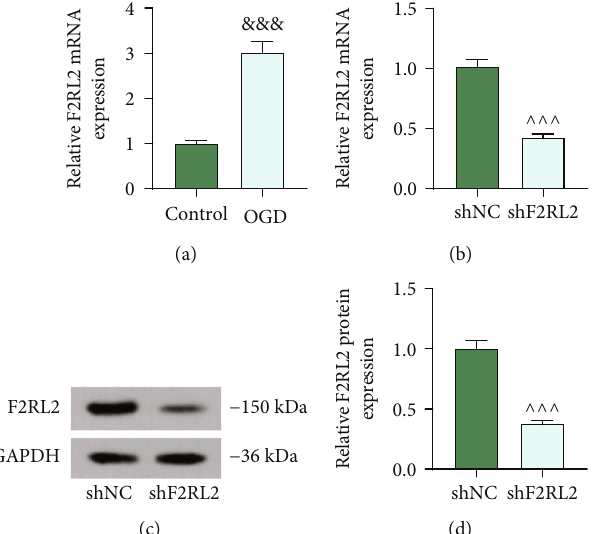
Figure 4: F2RL2 expression was upregulated in OGD-induced HCMs. (a) The expression of F2RL2 in OGD-induced HCMs was evaluated using qRT-PCR. (b – d) After cells were transfected with shF2RL2, the expression of F2RL2 in HCMs was examined using qRT-PCR (b) and Western blot (c, d). ( &&& P < 0 : 001 , vs. control; ^^^ P < 0 : 001 , vs. shNC) (HCMs: human cardiac myocytes; F2RL2: coagulation factor II thrombin receptor like 2; OGD: oxygen-glucose deprivation; qRT-PCR: quantitative